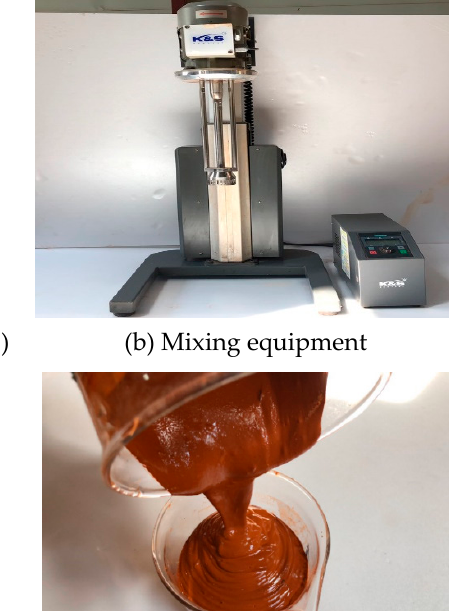
Table 3. Physical properties and chemical composition of OPC.